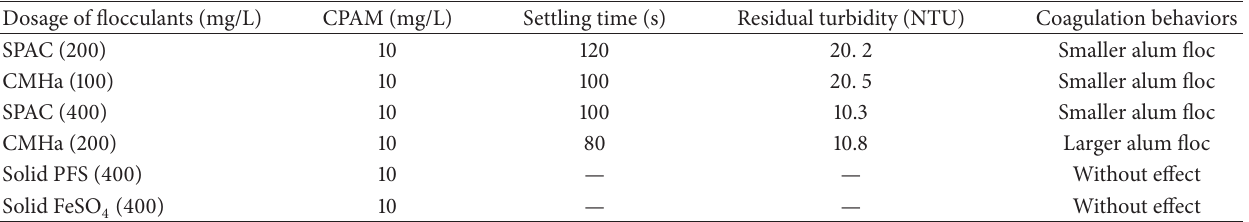
Table 13: Coagulation behaviors of CMHa versus PAC for dyeing-wastewater treatment (original wastewater 52 NTU). Dosage of flocculants (mg/L)